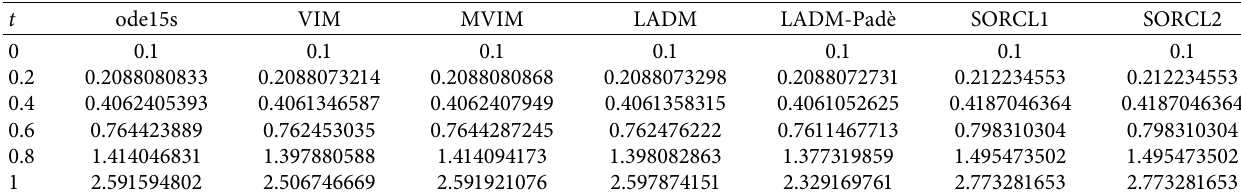
Table 1: Numerical comparison for values of T ( t ) , with ω � 0.57 and θ � 1 using diferent methods.